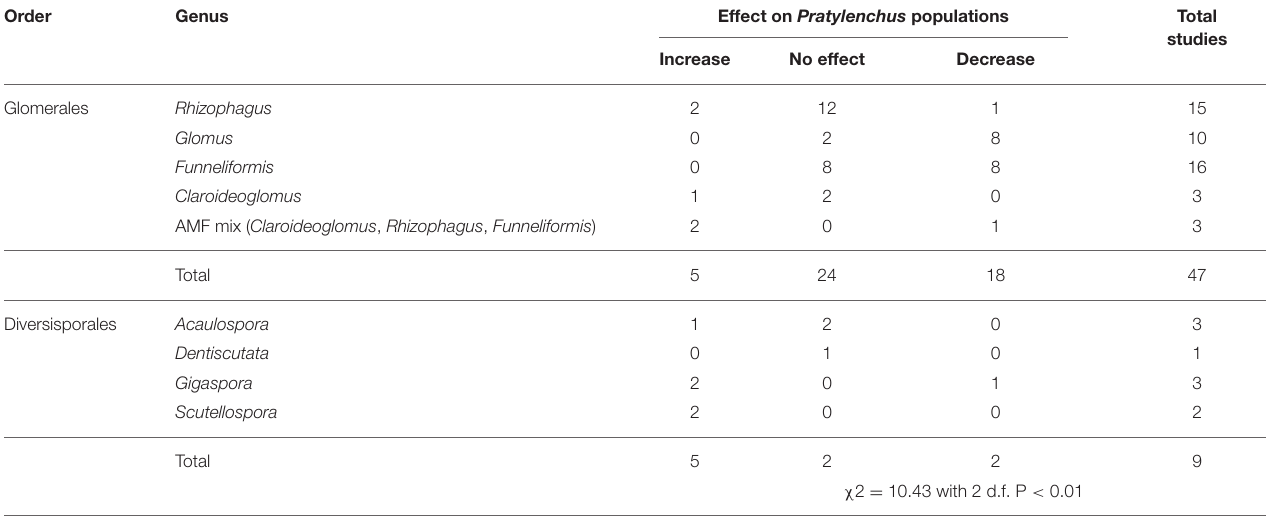
TABLE 4 | Number of studies investigating AMF- Pratylenchus interaction included in the systematic review and the effect of AMF order on Pratylenchus populations. Order Genus